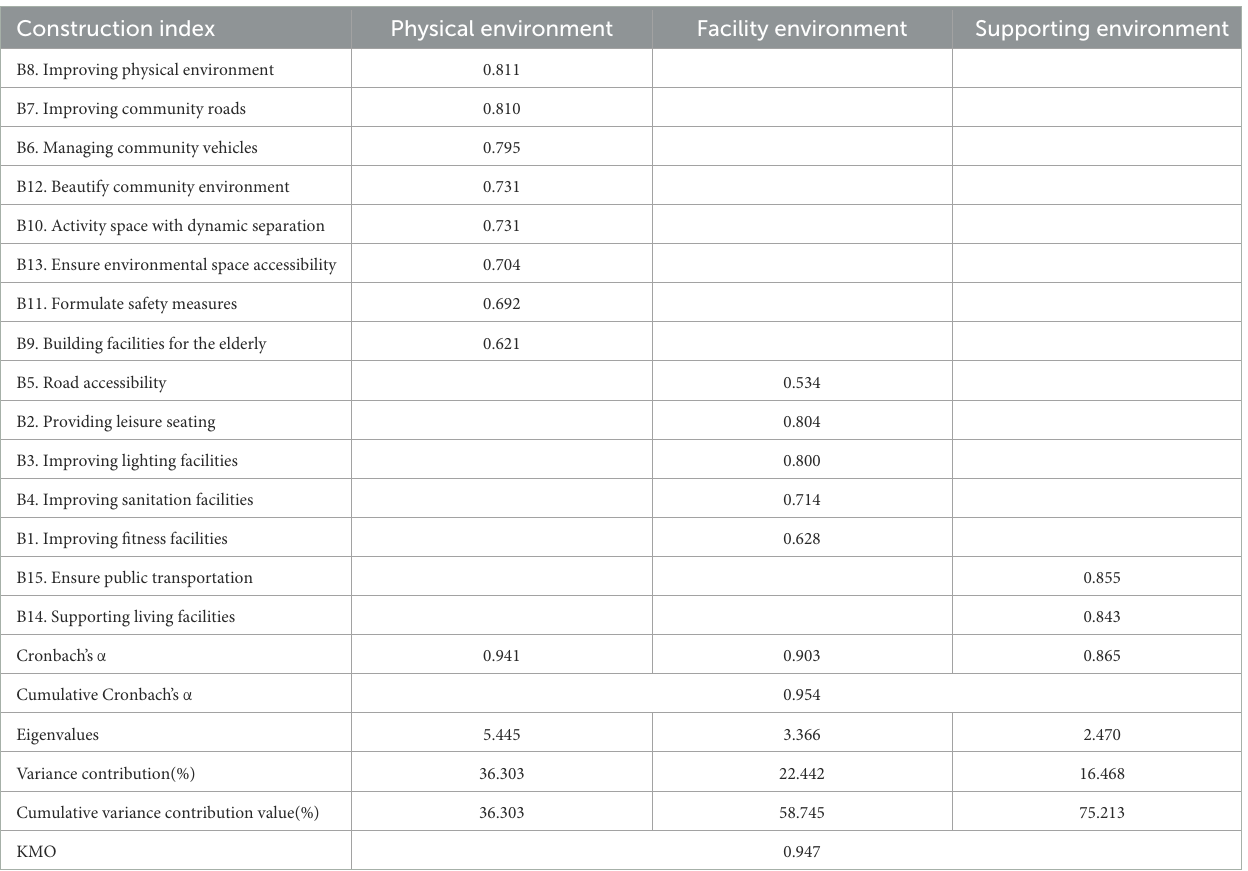
TABLE 3 Factor analysis result of “public environment”